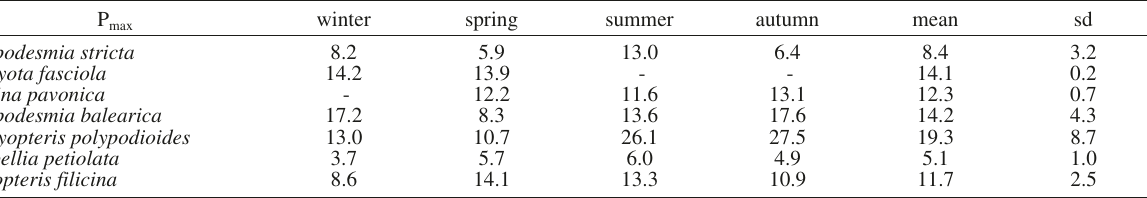
Table 2. – Results of the two-way ANOVA for P